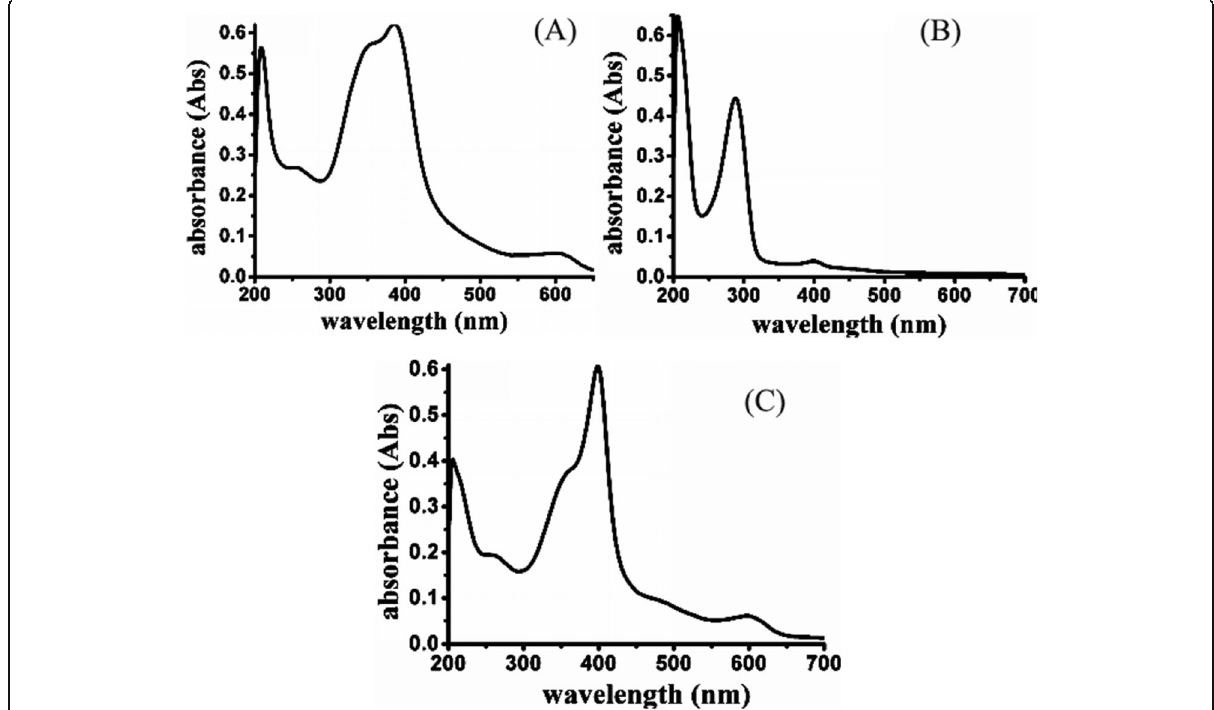
Fig. 3. UV-visible absorption spectra of hematin ( a ), Laminarin-S-S-MGK ( b ), and HLDM ( c )